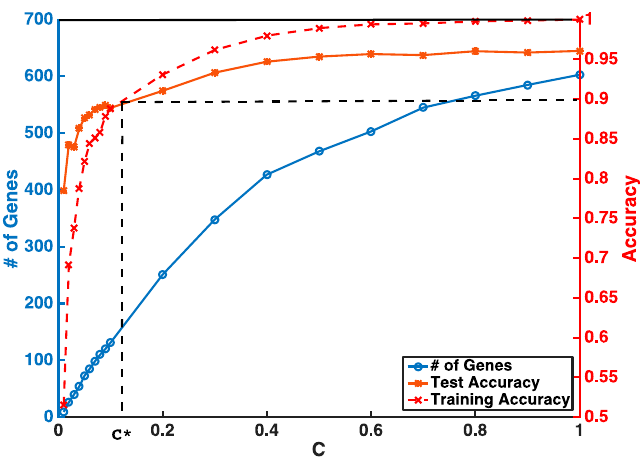
Figure 1. An example of a gene selection curve for the selection from all coding genes.